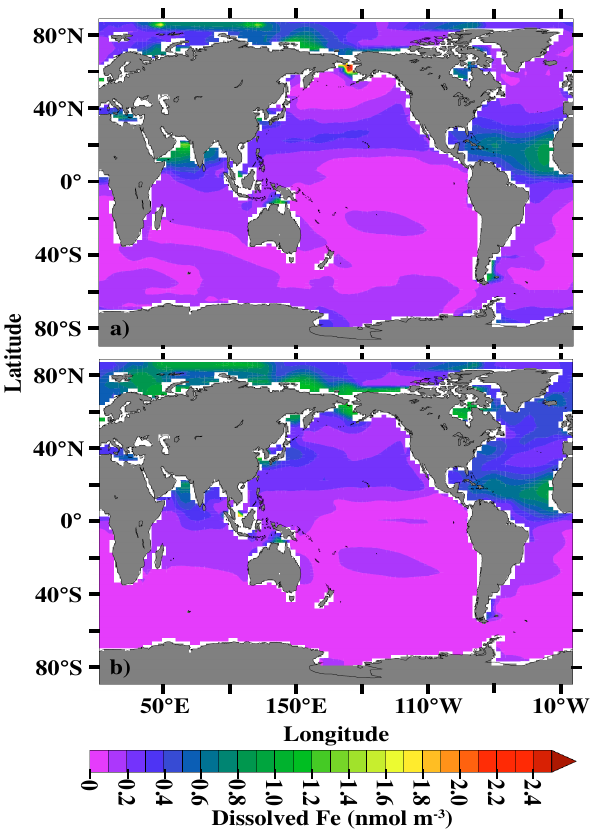
Fig. 3. Examples of the seasonably variable dissolved iron concen- trations used to constrain phytoplankton growth. Examples shown are for the surface layer in (a) January and (b)